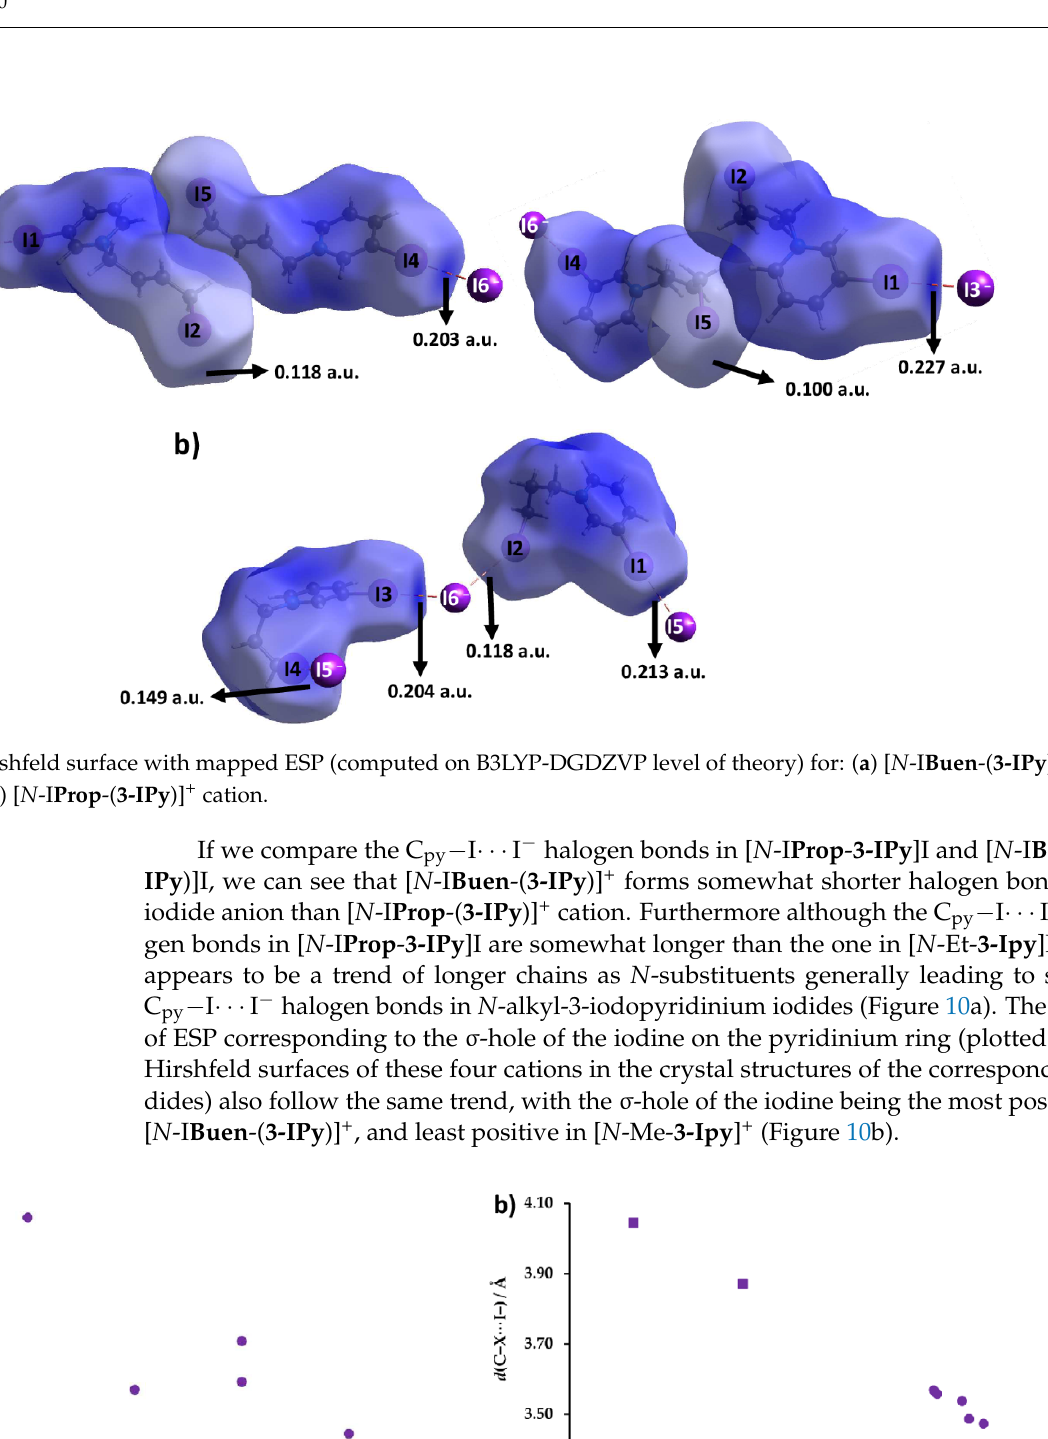
12 of 19 Figure 8. [ N -I Buen -( 3-IPy )] + cations and iodide anions connected through C − I ⋯ I − halogen and C − H ⋯ I − hydrogen bonds in cyclical [ N -I Buen -( 3-IPy )] 2 I 2 tetramers linked via C − H ⋯ I − hydrogen bonds into chains the structure of [ N -I Buen -( 3- IPy )]I.